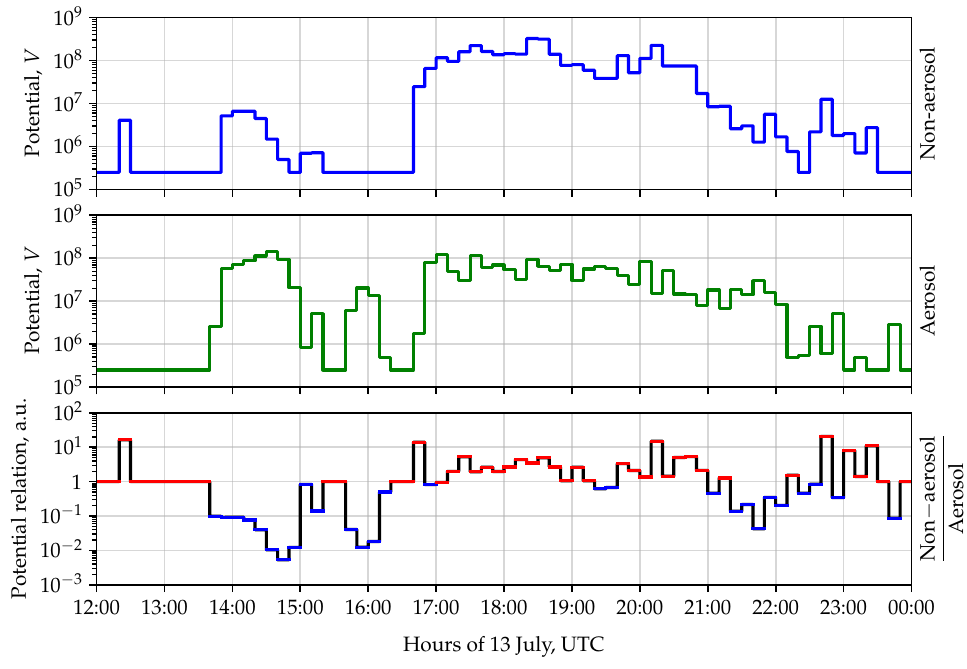
Figure 8. Thunderstorm in the Nizhny Novgorod region on 13–14 July 2020. Upper panel: time dependence of the maximum value of electric potential for non-aerosol parametrization of the microphysics. Central panel: time dependence of the maximum value of electric potential for aerosol parametrization of the microphysics. Lower panel: time dependence of the ratio of the maximum values of electric potential for non-aerosol and aerosol parametrizations of microphysics. The vertical axis is on a logarithmic